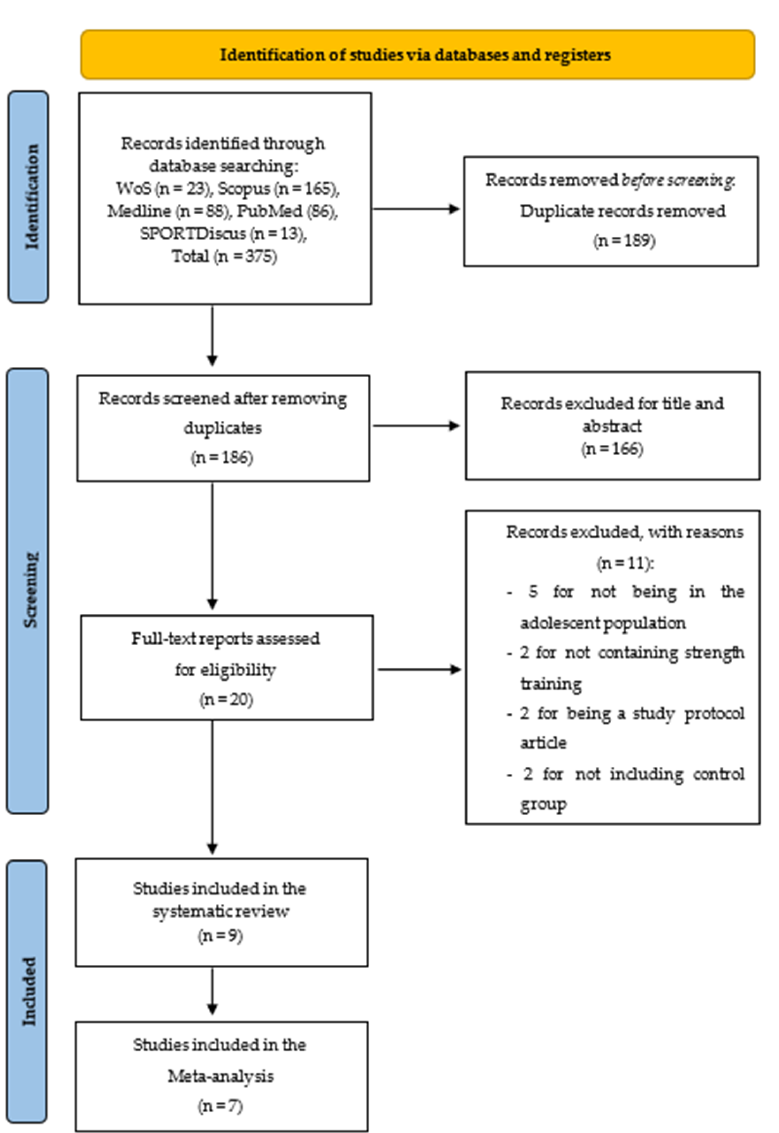
Figure 1. PRISMA flow diagram of articles that were selected.